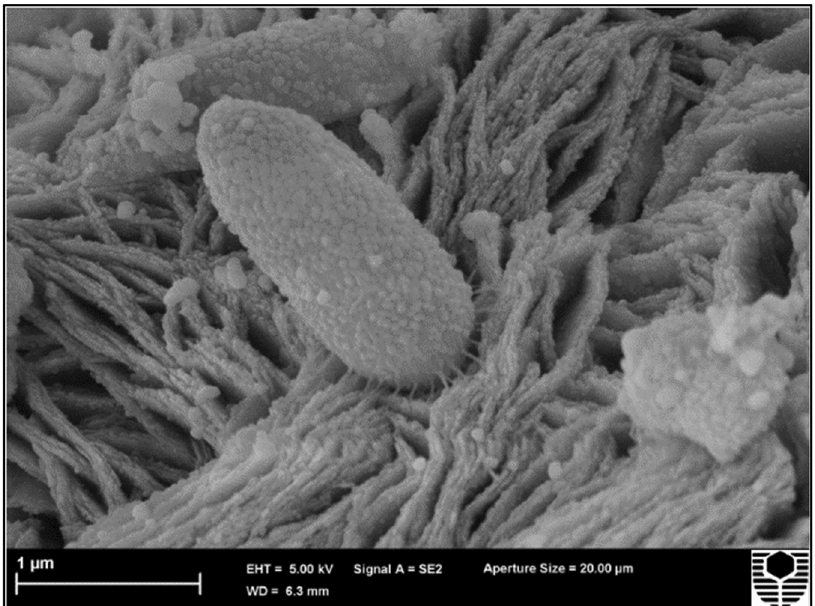
Fig. 1 Bacterial attachment to steel involving cellular appendages. Scanning electron microscopy (SEM) of Klebsiella pneumoniae adhesion after 24 h to CS (AISI 1030) where cellular appendages are utilised to interact iron